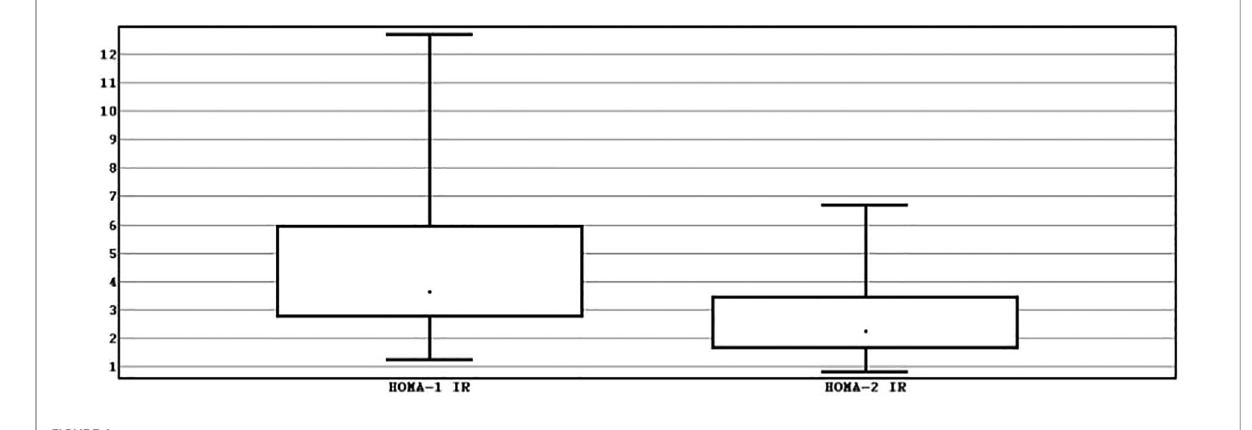
FIGURE 1 Interval evaluation of HOMA-1 IR and HOMA-2 IR.